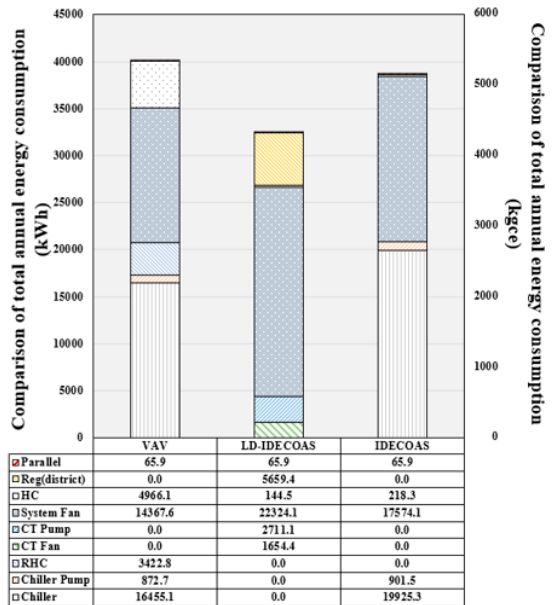
Figure 23. The total annual energy consumption of each system in the Guangzhou region.